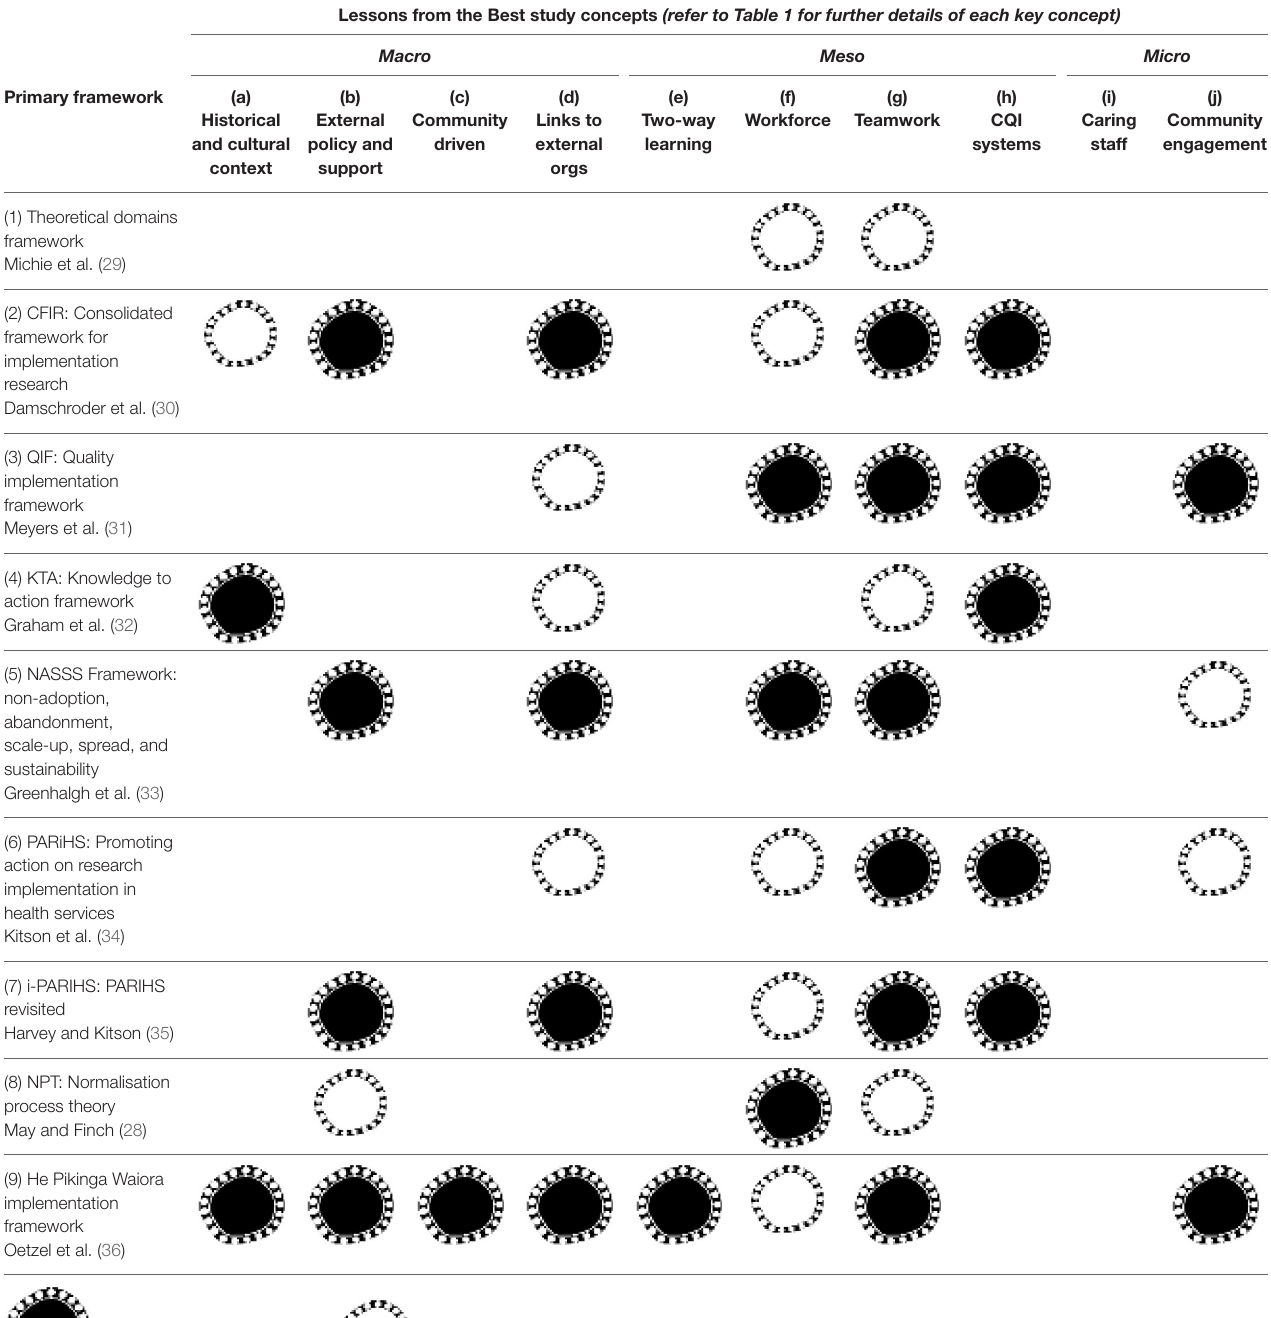
TABLE 3 | Mapping of primary